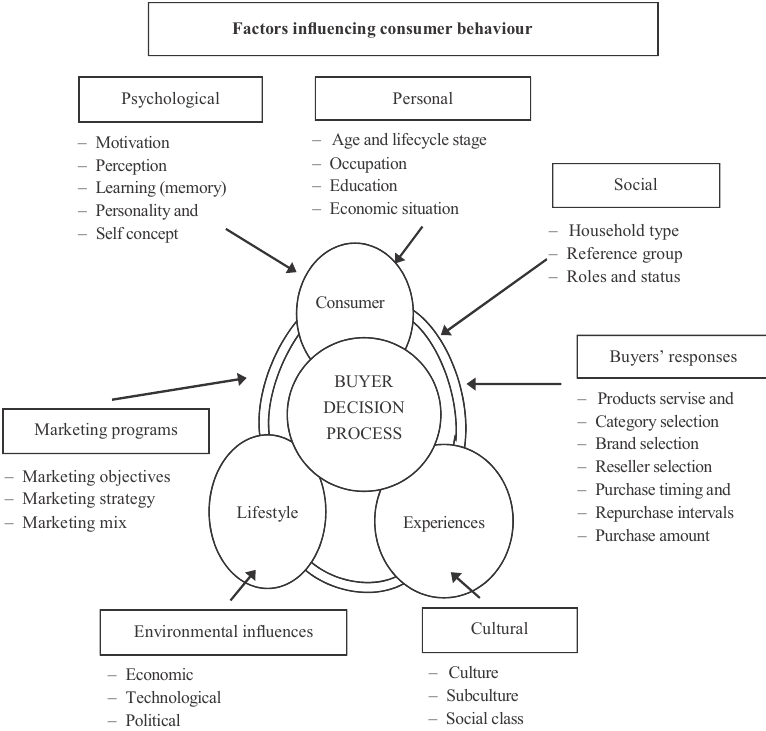
Fig. 2. Main factors that influence consumer behaviour (Consumer Voice Organization